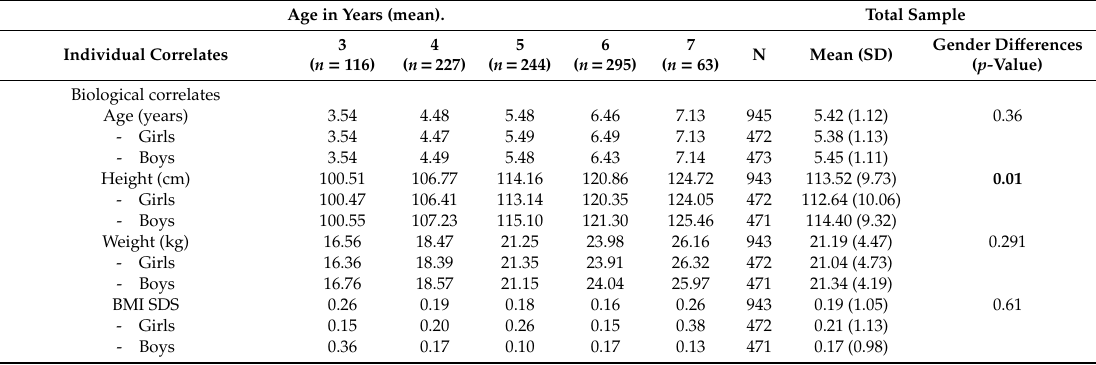
Table 1. Descriptive statistics of the study sample ( n =